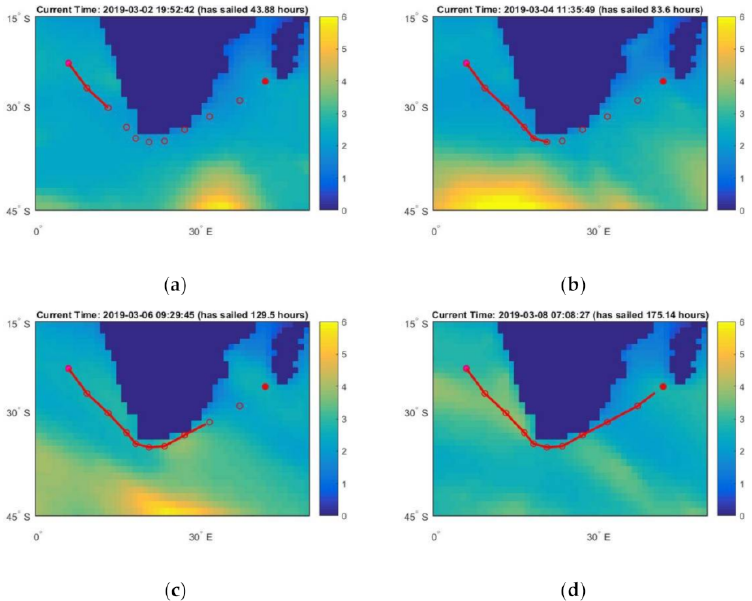
Figure 12. Position of the ship under complex offshore conditions at four different navigation times. ( a – d ) show the position of the ship with respect to the wave height map at different